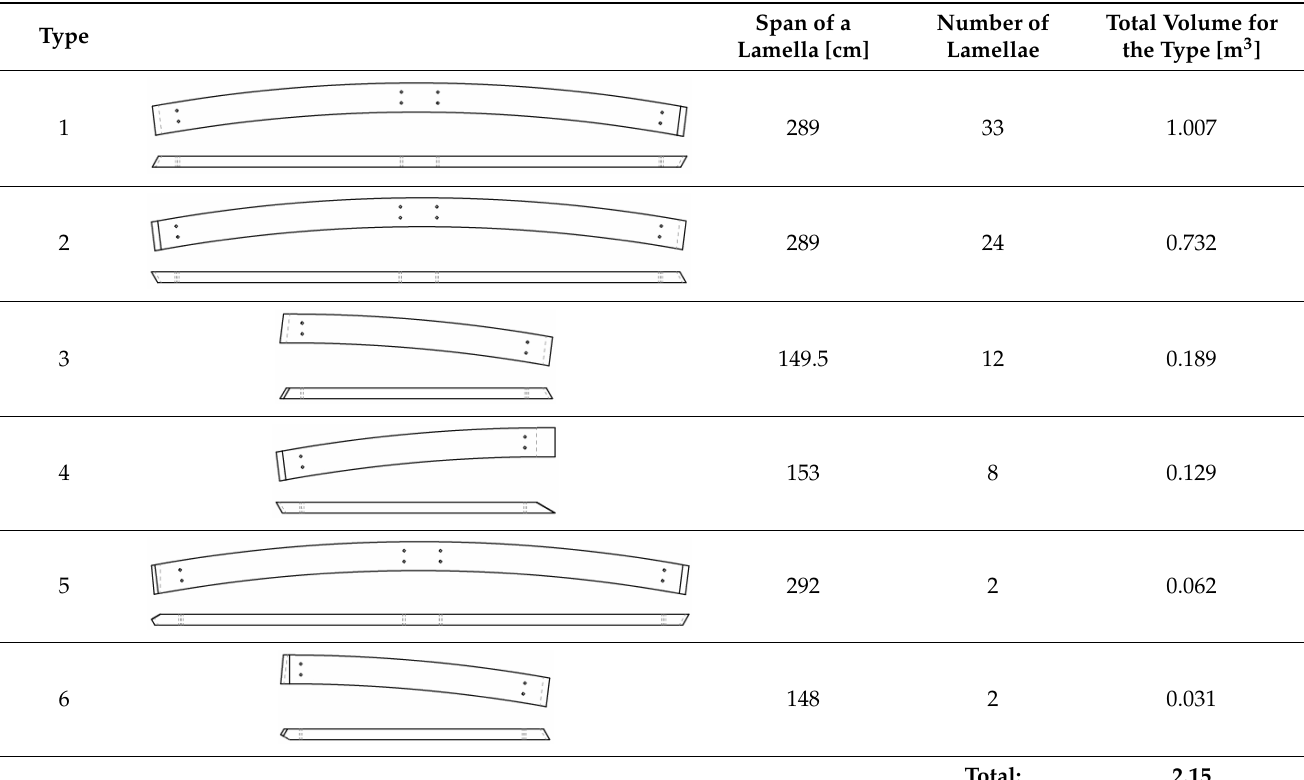
Table 1. Specification of timber